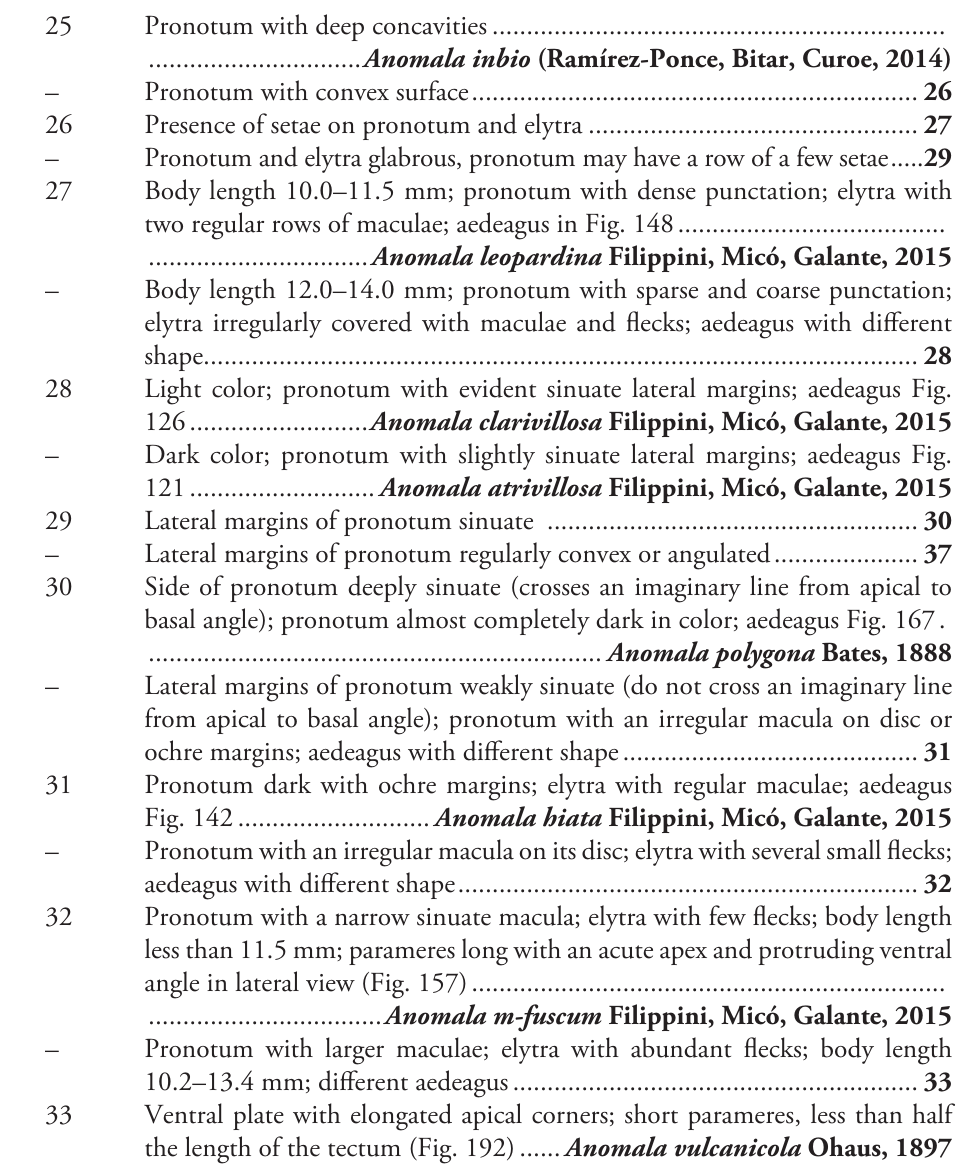
Pronotum with an irregular macula on its disc; elytra with several small